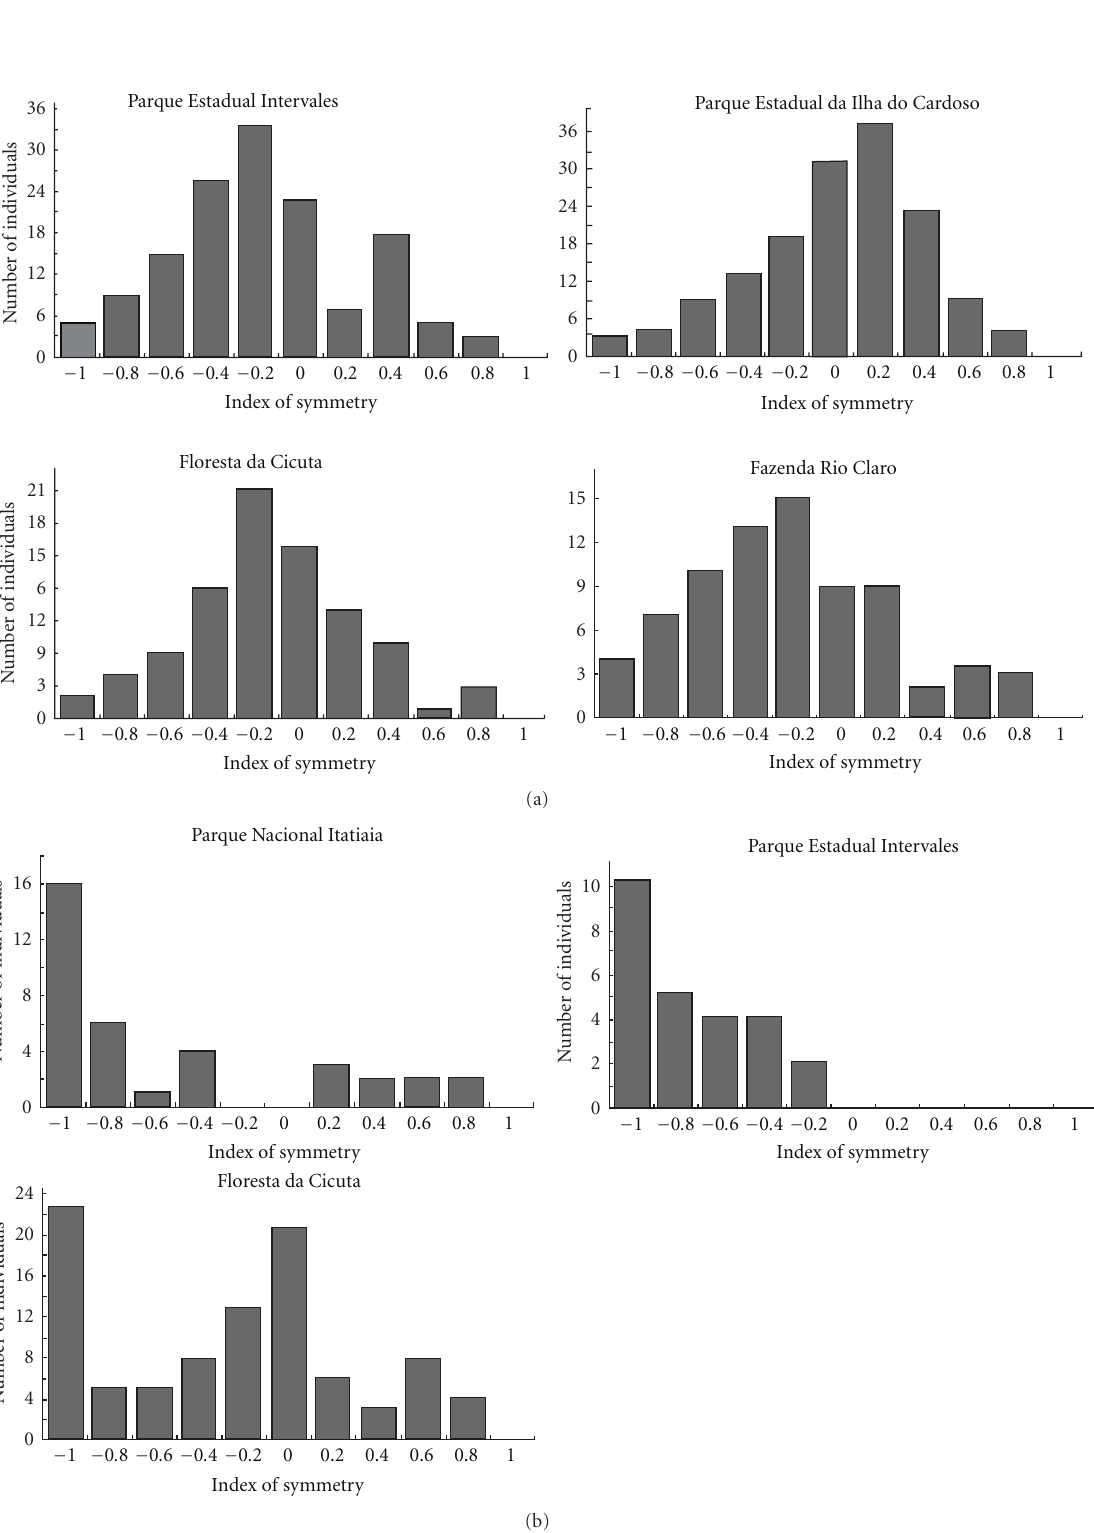
Figure 4: Positions occupied by adult (a) C. fililineata and (b) C. morretes in the detritus column in each population. − 1: lower extremity, 0: center, +1: upper